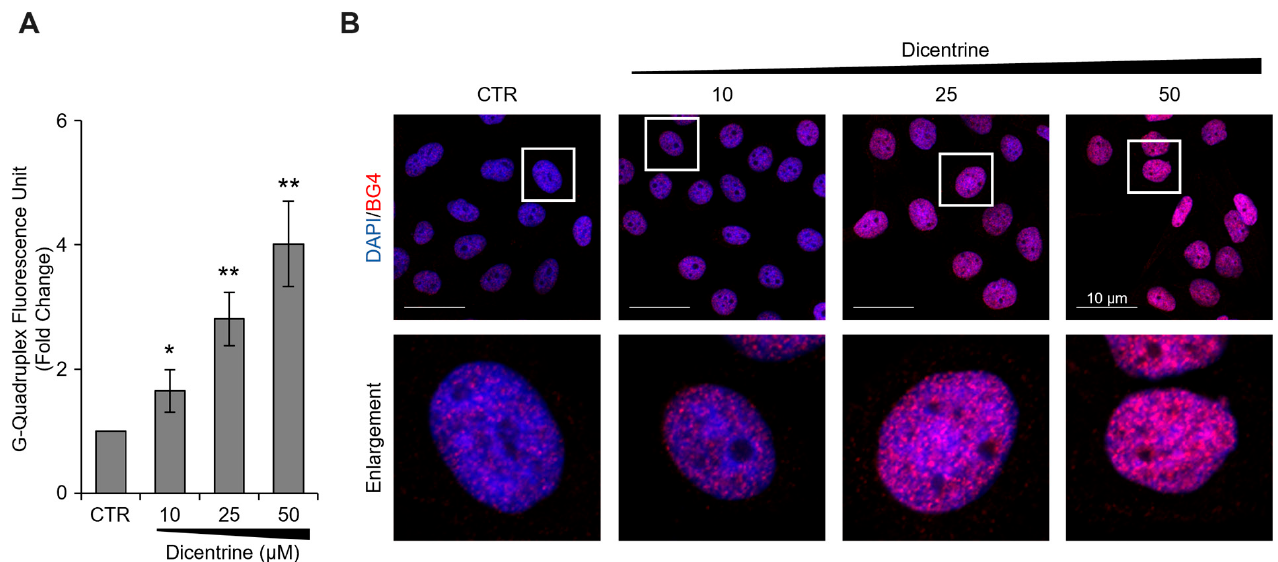
Figure 11. Biological evaluation of the G-quadruplex-stabilizing activity of Dicentrine. Immunofluorescence analysis of G-quadruplex structures in Hela cells treated for 24 h with DMSO (negative control) or with increasing doses of Dicentrine (10, 25, 50 µ M). ( A ) Quantitative analysis of the anti-G-quadruplex signal. For each panel, at least 25 cells/conditions were analyzed using the ImageJ software, and the results were expressed as the fold change in the fluorescence intensity over the negative control. Histograms show the mean ± SD of three independent experiments performed in triplicate. * p < 0.05; ** p < 0.01. ( B ) ) Upper Panels: representative images of confocal sections (63 × ) used for the detection of G-quadruplex structures. For each experimental condition, merged images of DAPI counterstained nuclei (blue) and G-quadruplex structures (red) are shown. Lower panels: enlargements (4 × ) of a single cell from each of the upper panels (white squares) are shown. Scale bars (10 µ m) are reported in the figures.